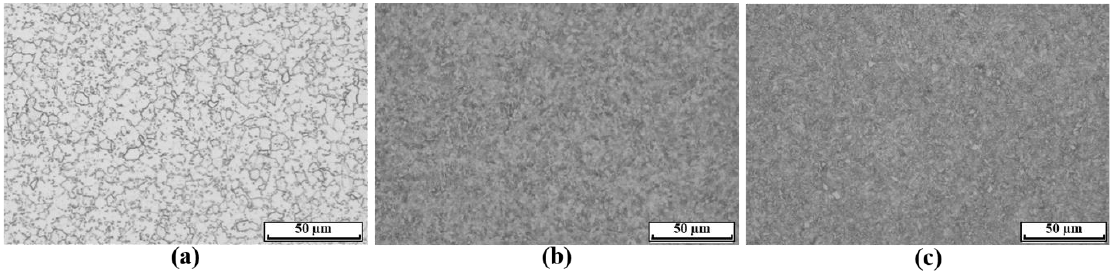
Figure 3. Comparison of light microscopic images of ( a ) base material, ( b ) QP1 and ( c ) QP2. To get a more detailed analysis of the microstructural development according to the different heat treatment routes, scanning electron microscopy was carried out. Figure 4 shows a characteristic area of QP1 in different magnifications.